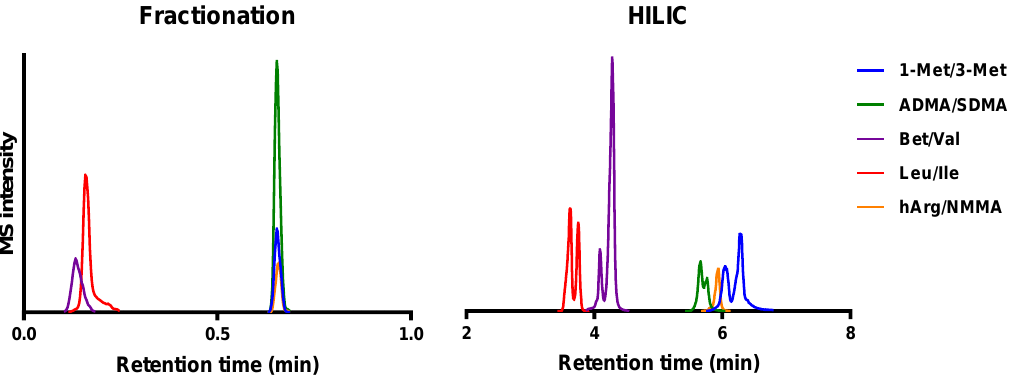
Figure 1. Extracted ion chromatograms of five structural isomer pairs measured in positive ionization mode. The fractionation method does not demonstrate chromatographic separation within an isomer pair. The hydrophilic interaction liquid chromatography (HILIC) method does demonstrate slight chromatographic separation within an isomer pair.